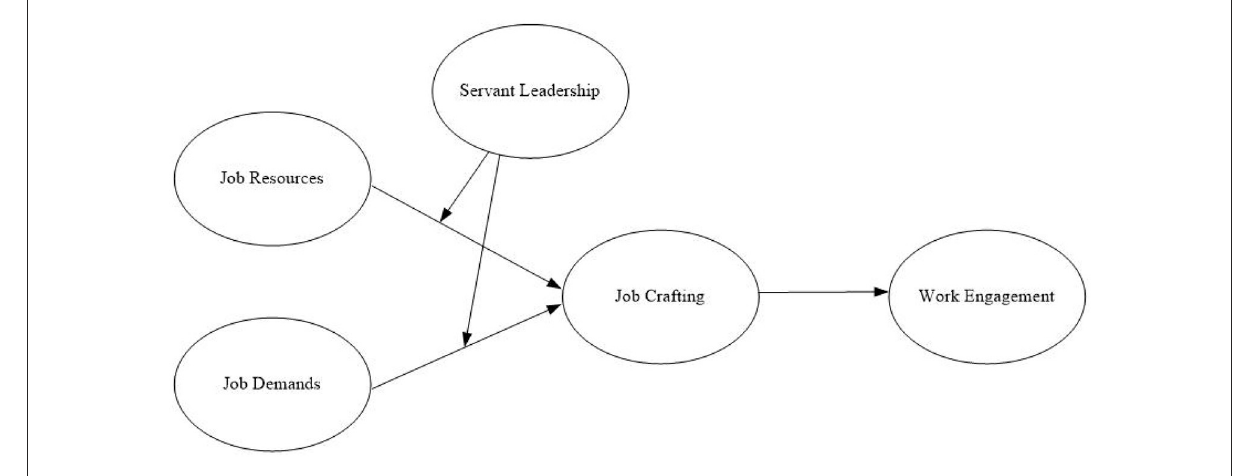
FIGURE1 Research